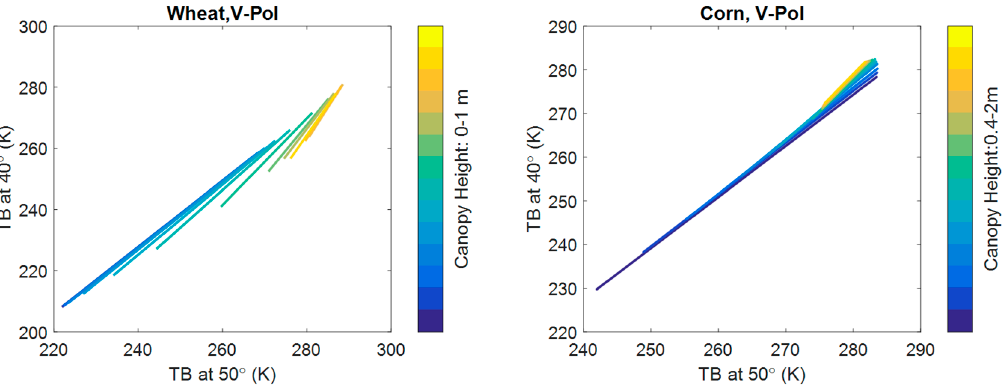
Figure 2. Simulation brightness temperature observation in vertical polarization in 40–50 incident angle for wheat (left) and corn (right) . angle for wheat ( left ) and corn ( right